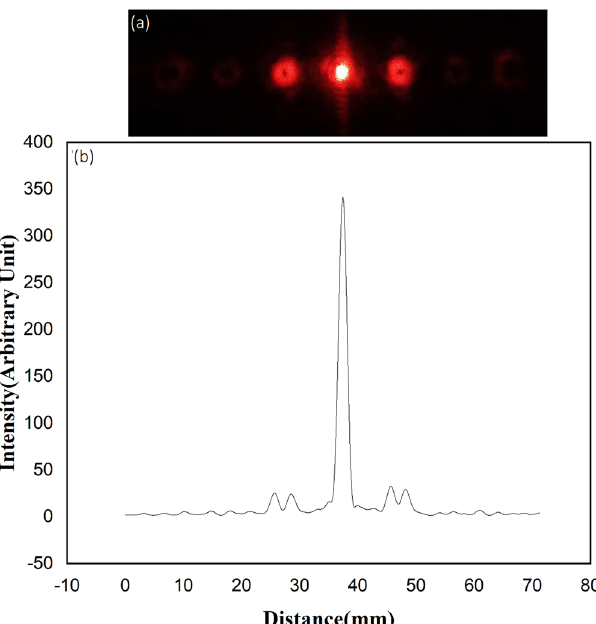
Figure 10. ( a ) The image of the diffracted beam from the stored pattern in the sample without applying voltage, ( b ) the profile of the diffracted